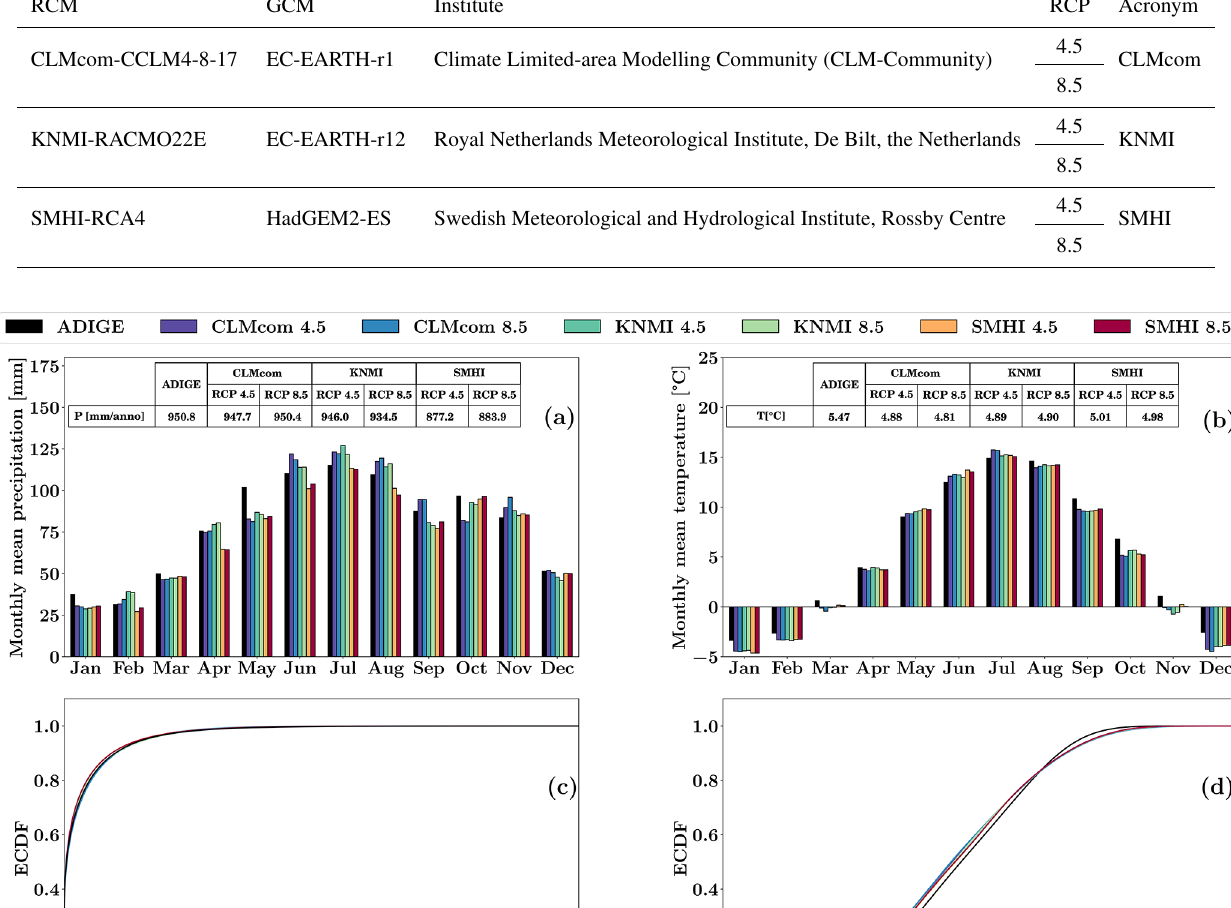
Table 2. List of the EURO-CORDEX CMs used in this study. The acronyms adopted are listed in the last column. RCM